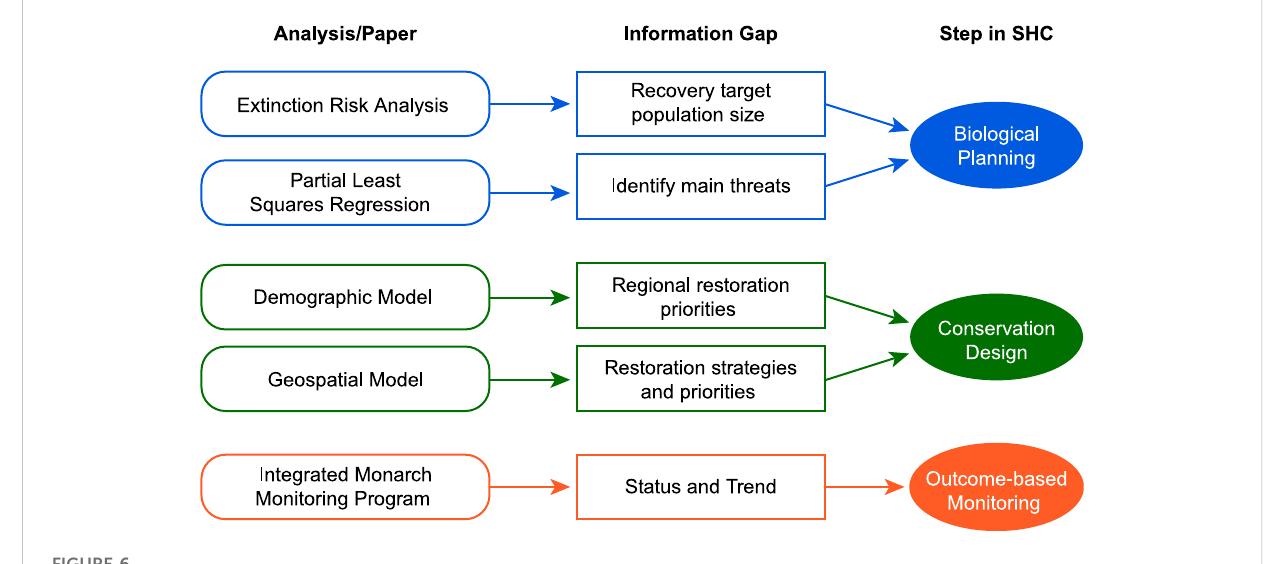
FIGURE 6 Analyses performed by the MCSP, the key information gap those analyses fi lled, and the associated step in